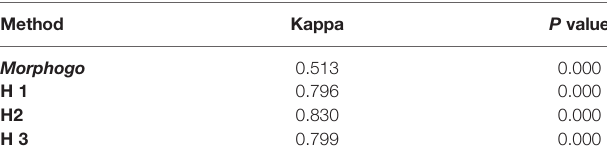
TABLE 4 | Evaluation of the consistency between the pathologists/Morphogo (classi fi cation threshold = 0.426) and the gold standard in terms of Cohen kappa coef fi